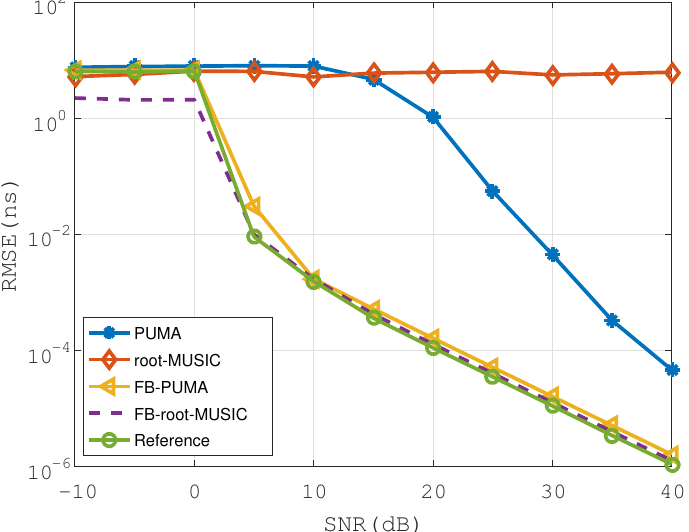
Figure 5. RMSE versus SNR, K = 3; the 2 overlapping echoes are fully correlated with each other, but uncorrelated with the surface echo (Scenario 2).